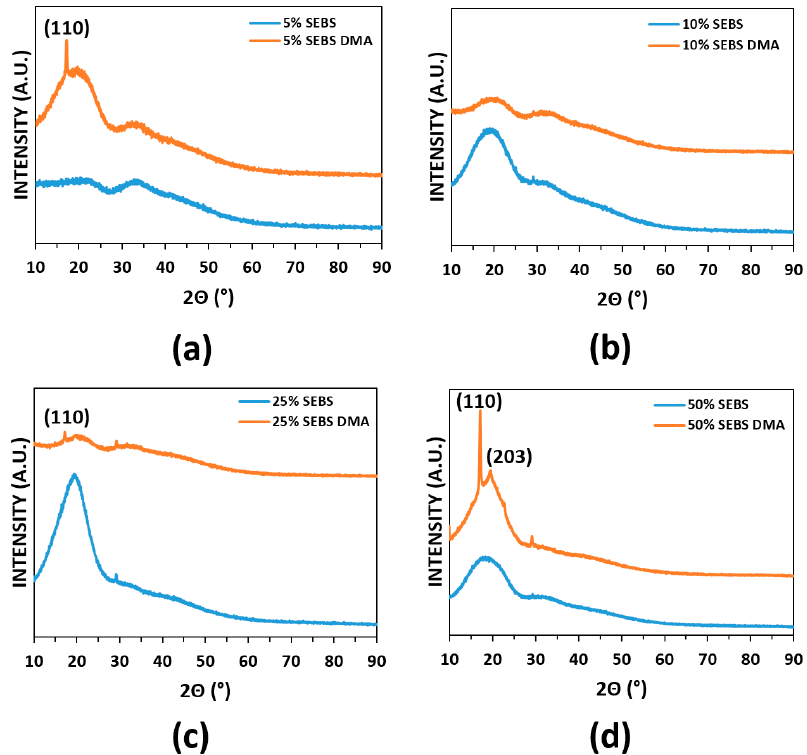
Figure 7. XRD spectra of the PLA:SEBS blend combination before and after DMA testing where ( a – d ) correspond to 5, 10, 25, and 50% by weight SEBS, respectively.